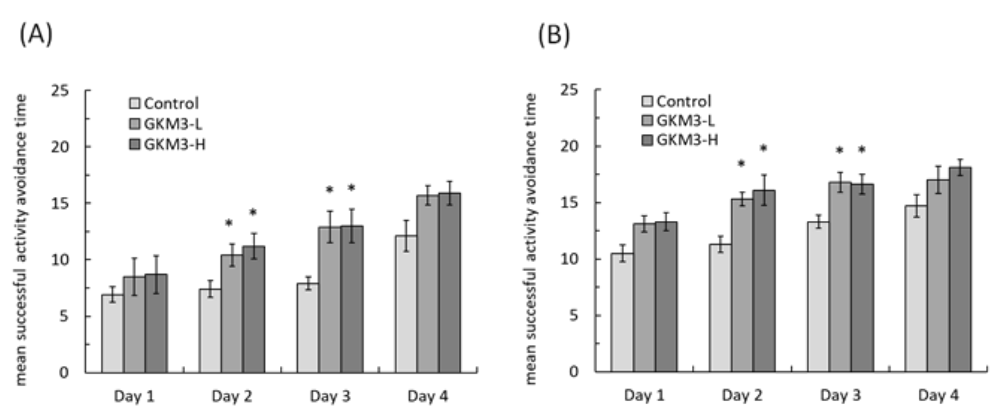
Figure 3. Active avoidance ability of male ( A ) and female ( B ) SAMP8 mice. Values are presented as mean ± S.E.M. (n = 10). * p <0.05 was regarded as a significant difference (one-way ANOVA). GKM3-L: 1.0 × 10 9 CFU/kg BW/day (low dose); GKM3-H: 5.1 × 10 9 CFU/kg BW/day (high dose).